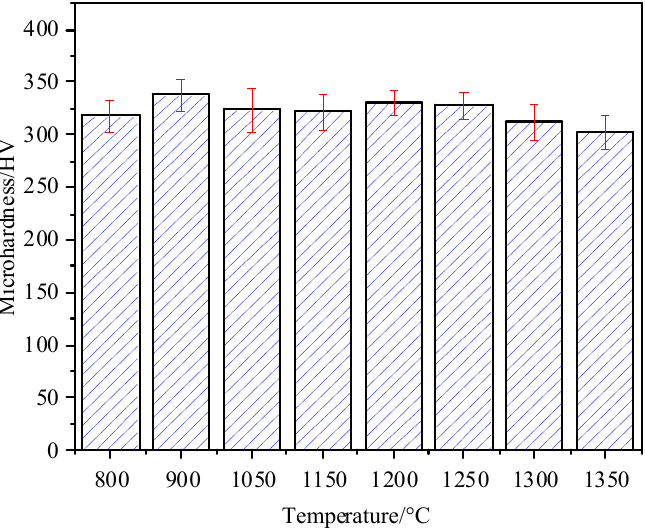
Figure 8. Microhardness values of simulated HAZ at different peak temperatures.